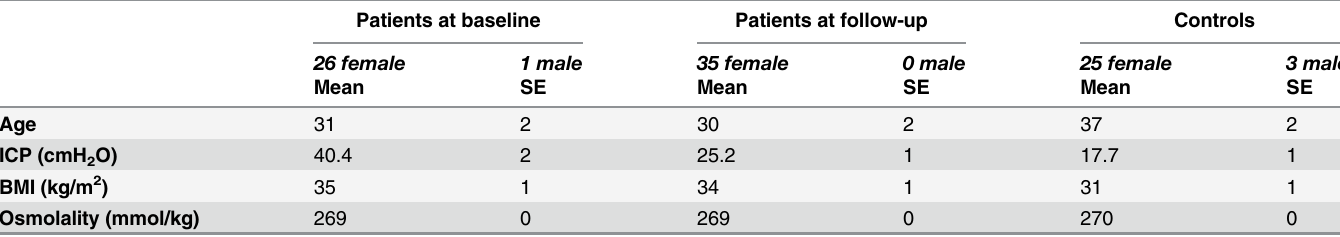
Table 1. Demographics of patients and controls. Patients at baseline Patients at follow-up